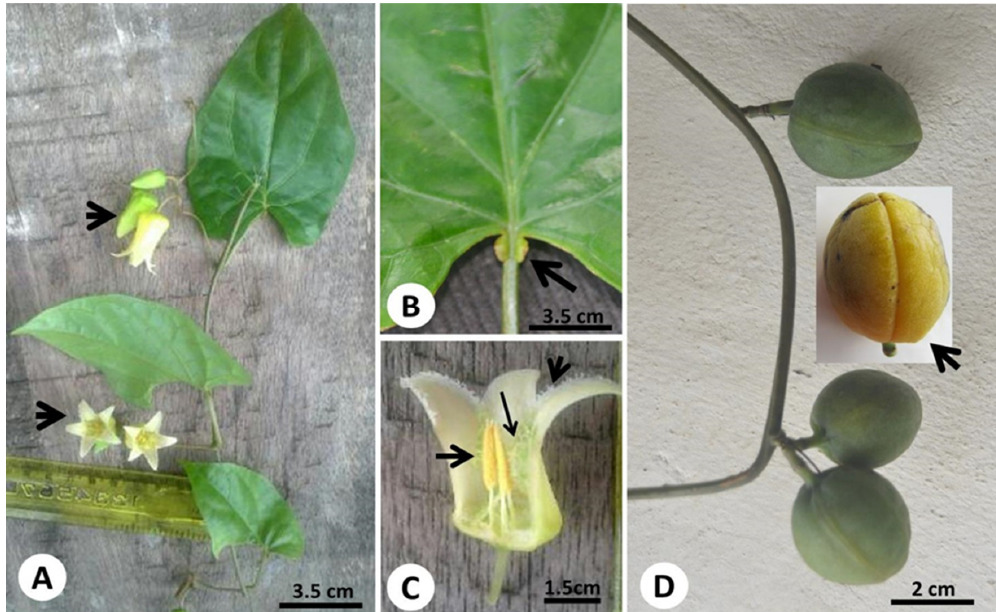
Figure 1(A-D): A. lobata (A) Plant habit (arrows show flower buds), (B) Leaf (arrow shows glands), (C) Flower arrows show styles and hairs, and (D) ripped and unripped fruits (arrow shows ripped fruit)